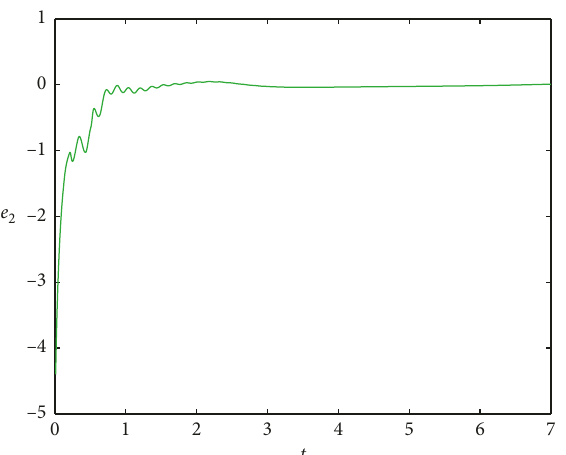
Figure 5: Combination synchronization errors e